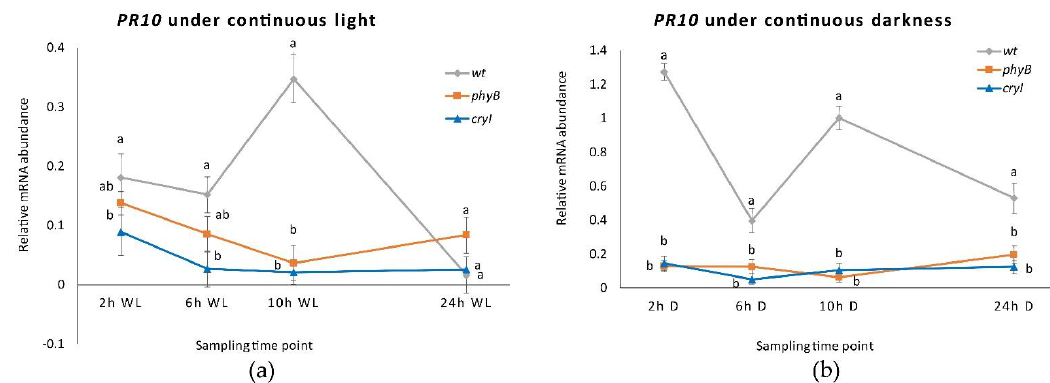
Figure 9. PR10 expression in Dar Gazi-wt , Dar Gazi-phyB , and Dar Gazi-cry1 : ( a ) in 24 h continuous light, panel; ( b ) in 24 h continuous darkness. Results are presented after normalization with ef1A . Data shown as the average of two biological replicates run in triplicate, with error bars representing SD. At each time point values with different letters significantly differ according to the analysis of the variance (ANOVA) and least significant difference (LSD) tests ( p ≤ 0.05).